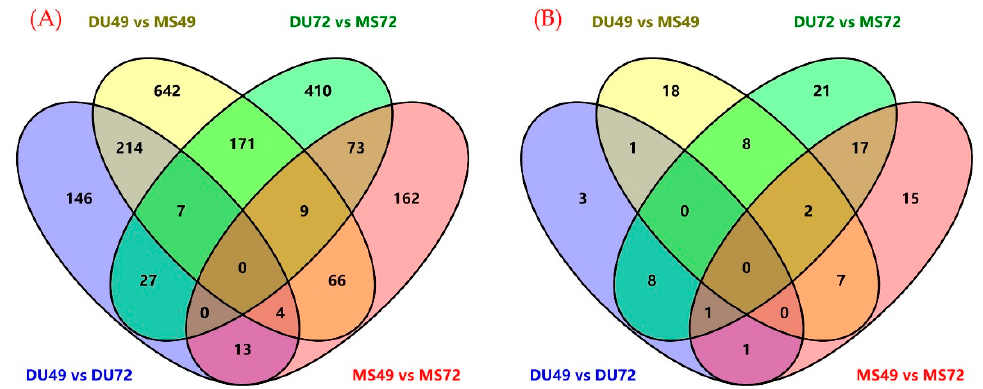
Figure 1. Venn diagram displaying the overlap among different groups of differentially expressed genes (DEGs) ( A ), differentially expressed (DE) miRNAs ( B ).